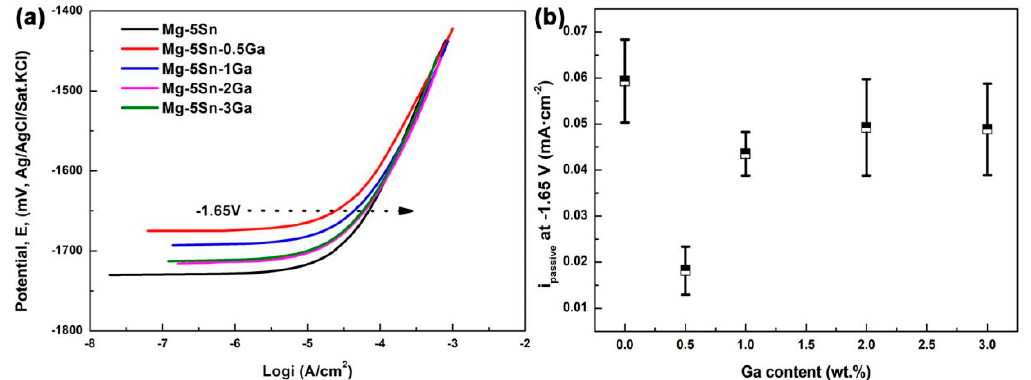
Figure 5. ( a ) The representative polarization curves of the Mg–5Sn– x Ga alloys in 0.01 M NaCl solution. ( b ) Passive current density ( i passive ) values measured at − 1.65 V based on ( a ). The average and standard deviation were obtained from at least five measurements.